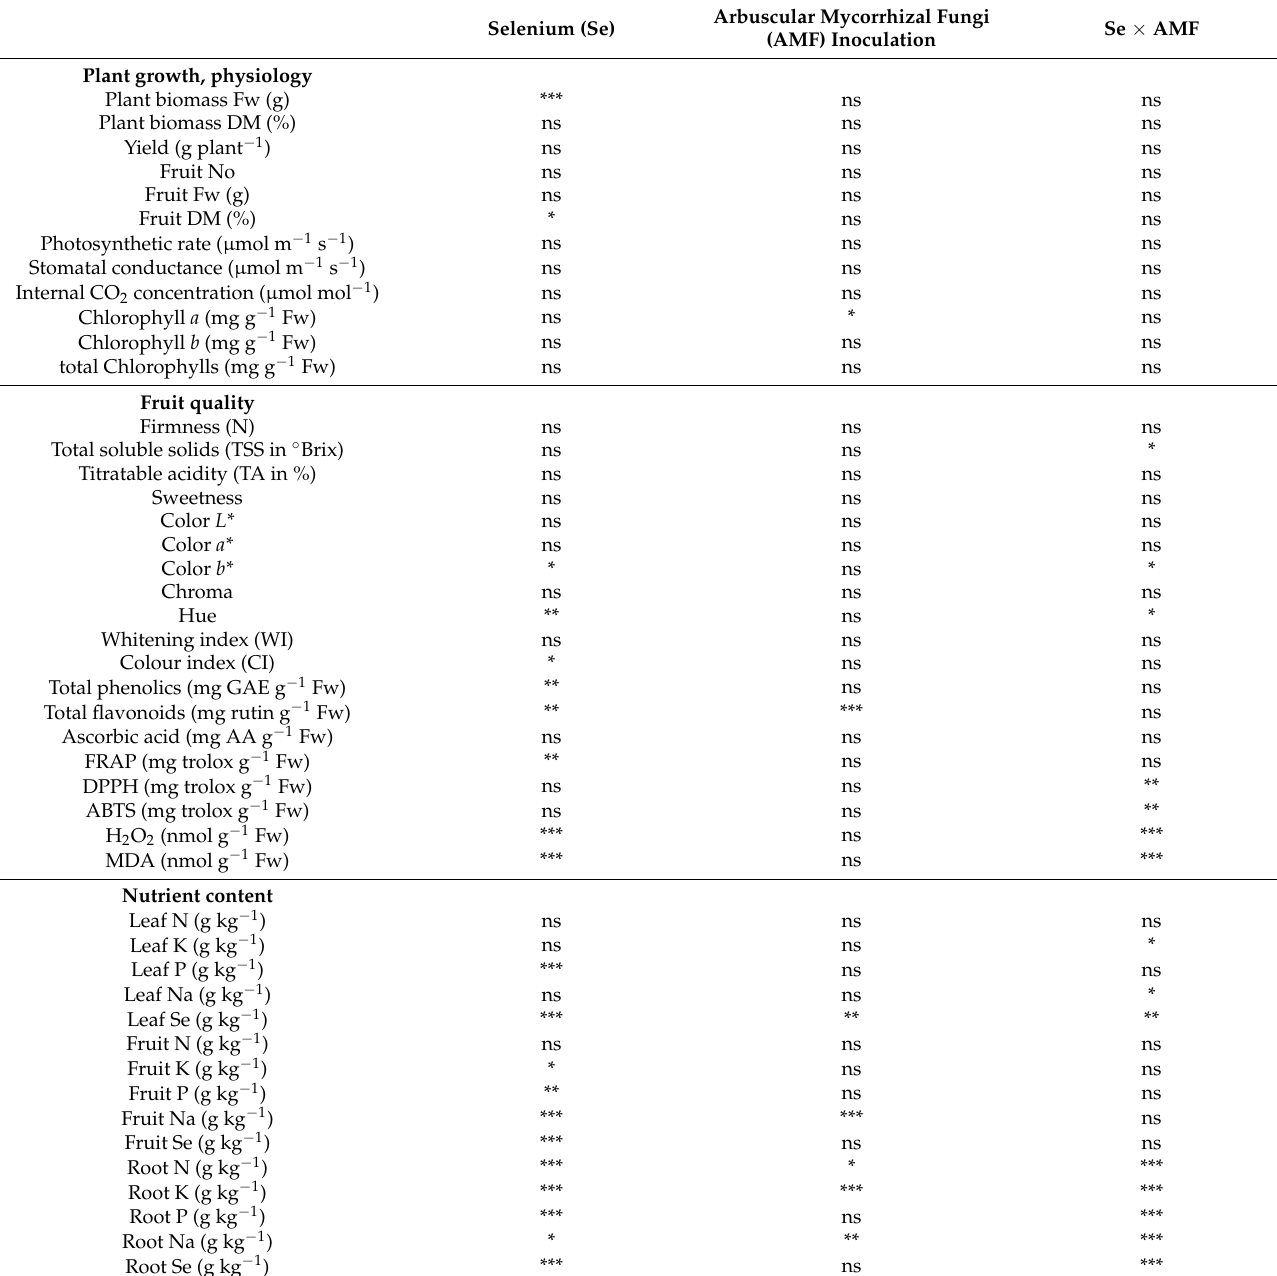
Table 1. Effects of selenium (Se) levels, arbuscular mycorrhizal fungi (AMF) inoculation and their interaction on strawberry plant growth, physiology and nutrient